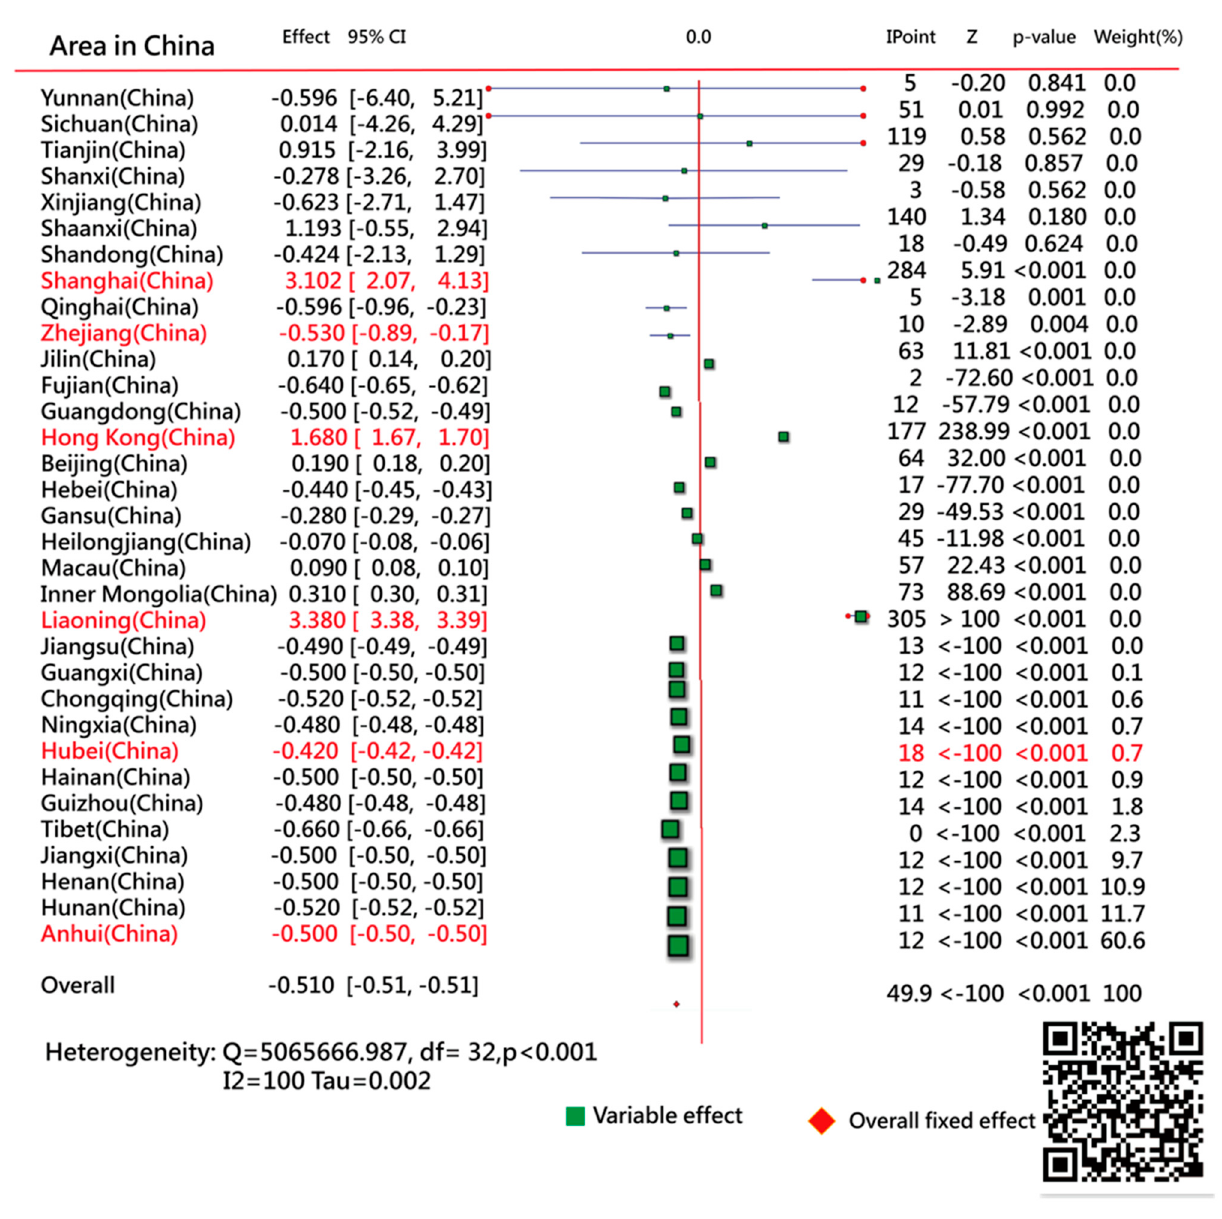
Figure 6. Comparison of IP days among regions in China using the forest plot. We observed that the top three areas having aberrant CNIC patterns were Yunnan, Sichuan, and Tianjin, with IP days at 5, 51, and 119, respectively (Figure 7). The provinces of Anhui, Hunan, and Henan had the most model-data-fit regions (having a smaller number of residuals) with IP days of 12, 11, and 12, respectively (Figure 8). The IP-day variable for Hubei (including Wuhan) was 18.